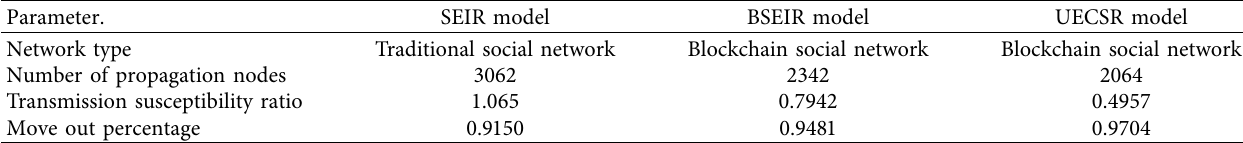
Table 5: Comparison table of the three different models.